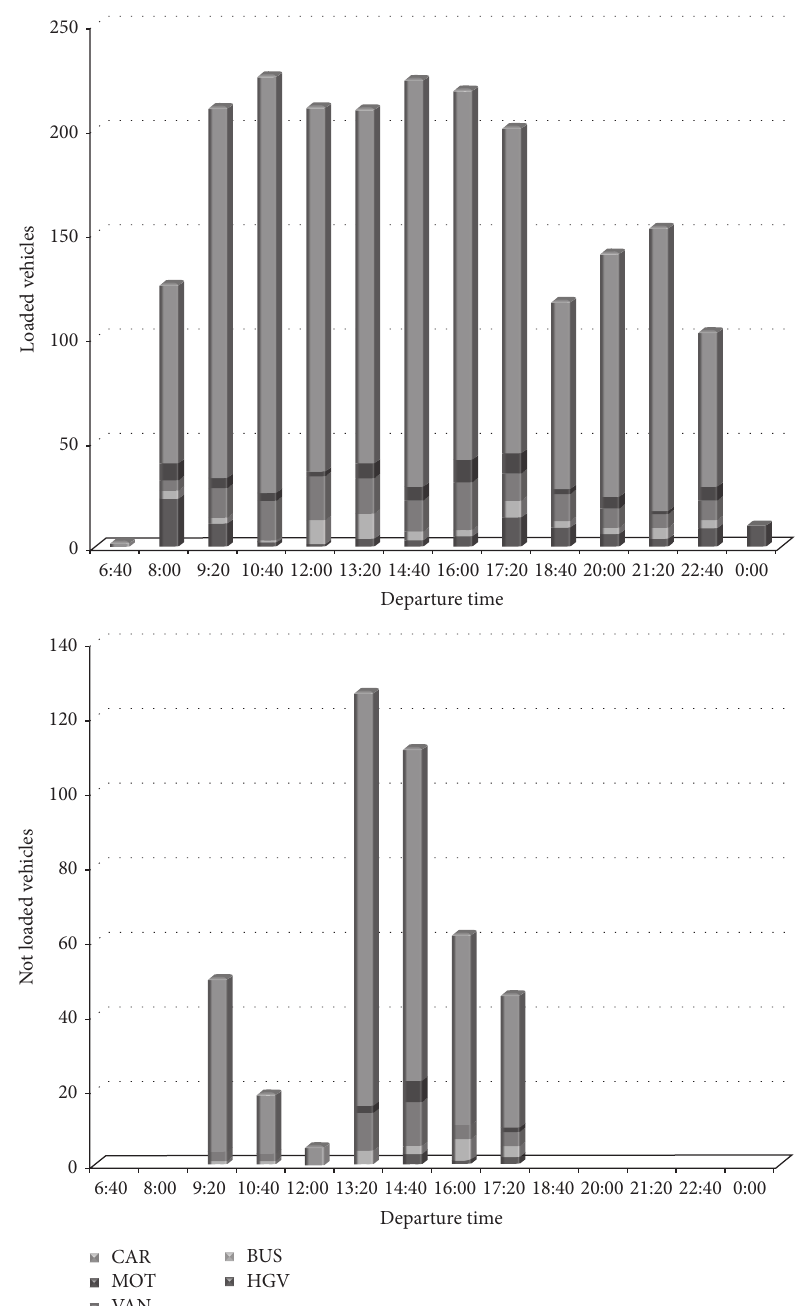
Figure 10: Vehicles embarking and remained on the pier for any run of the ferry, second